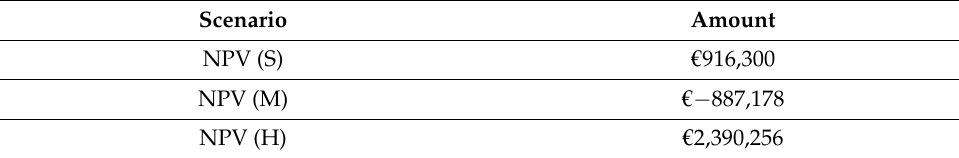
Table 13. Eventual net present values of large battery storage